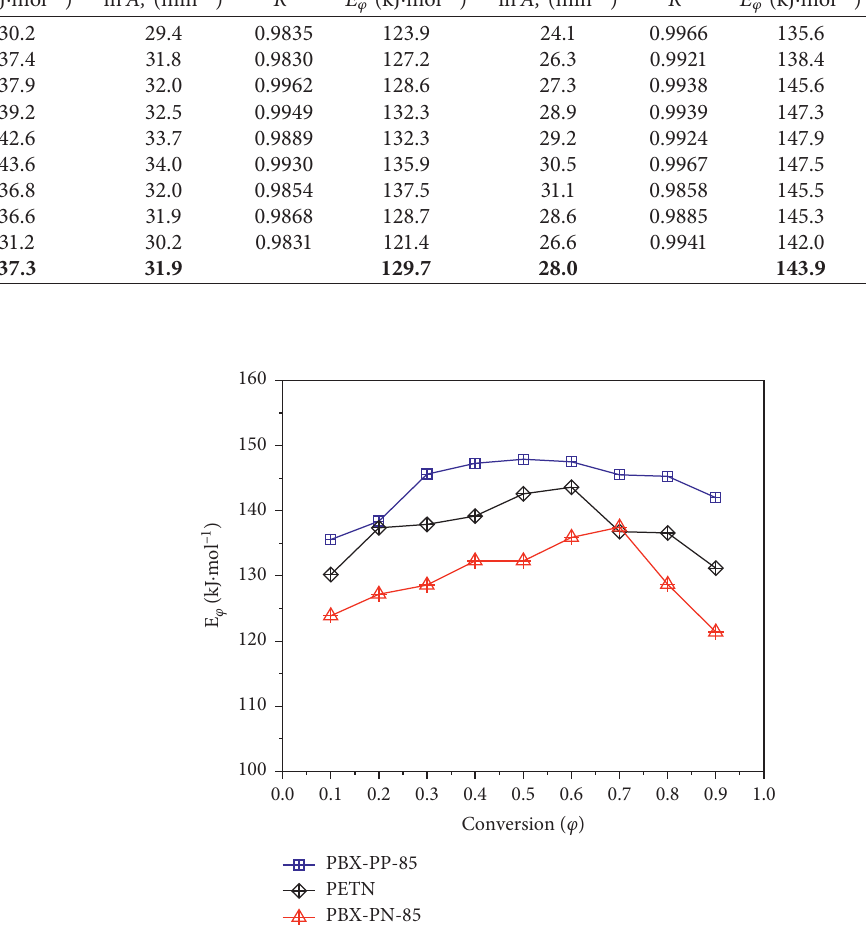
Figure 6: The dependence of activation energy on the conversion using the VST technique.